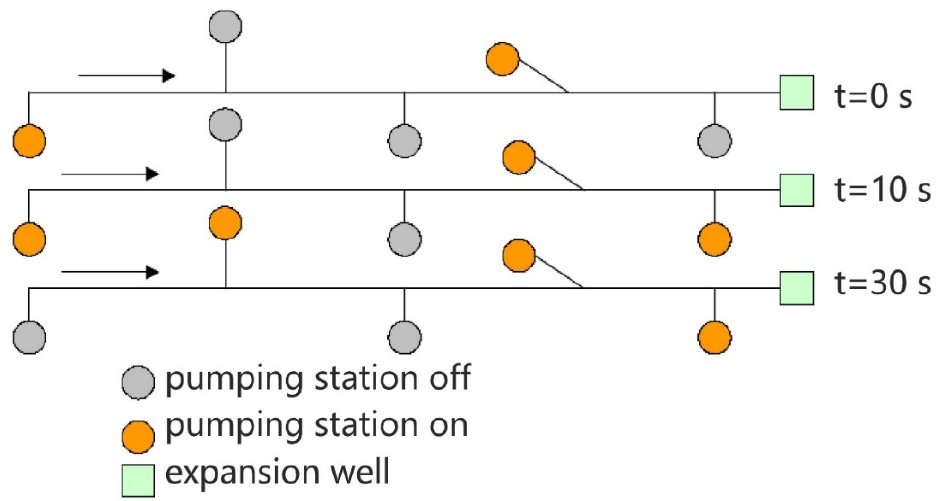
Figure A3. Schematic of pump function during simultaneous pressure system investigation.